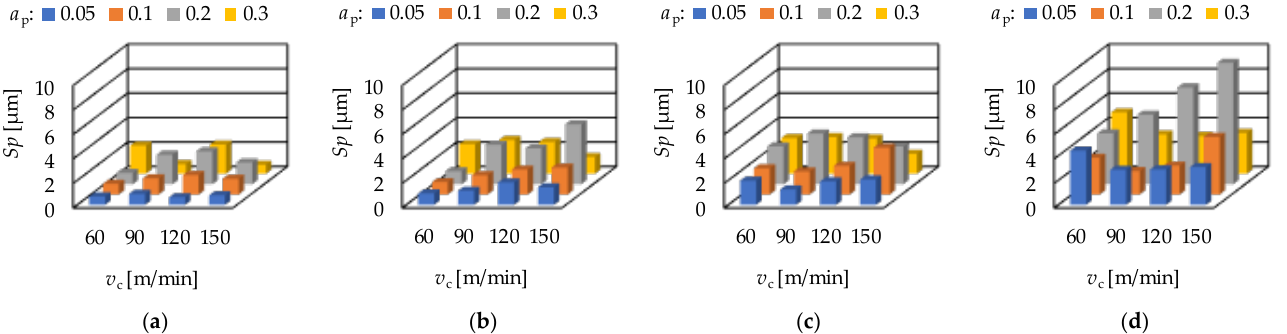
Figure 7. The measured maximum peak height ( Sp ) values for hard turning by applying ( a ) f = 0.05 mm/rev, ( b ) f = 0.1 mm = rev, ( c ) f = 0.15 mm/rev, ( d ) f = 0.2 mm/rev.